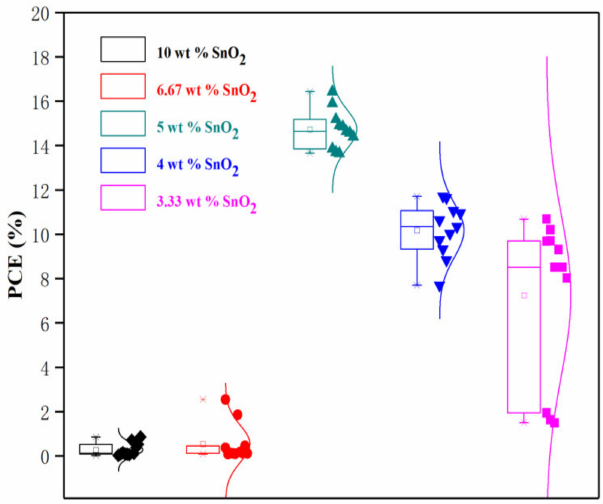
Figure 4. The statistical plots of PCE of reverse scanned data. The average value is demonstrated with the boxes. The third quartile and first quartile are demonstrated with lower and upper box boundaries, respectively. The minimum and maximum values are demonstrated with the whiskers, and the median is demonstrated with the middle line in each box. Eleven devices in each group are prepared under the same